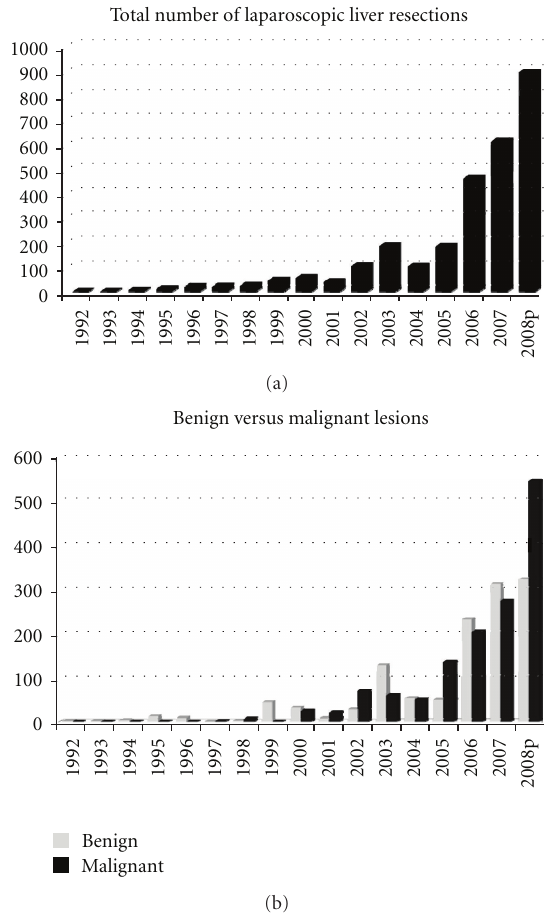
Figure 2: Increase in reported MILRs over time (2002–2008 (partial)). Reproduced from Nguyen et al. Annals of Surgery 2009; 250: 831